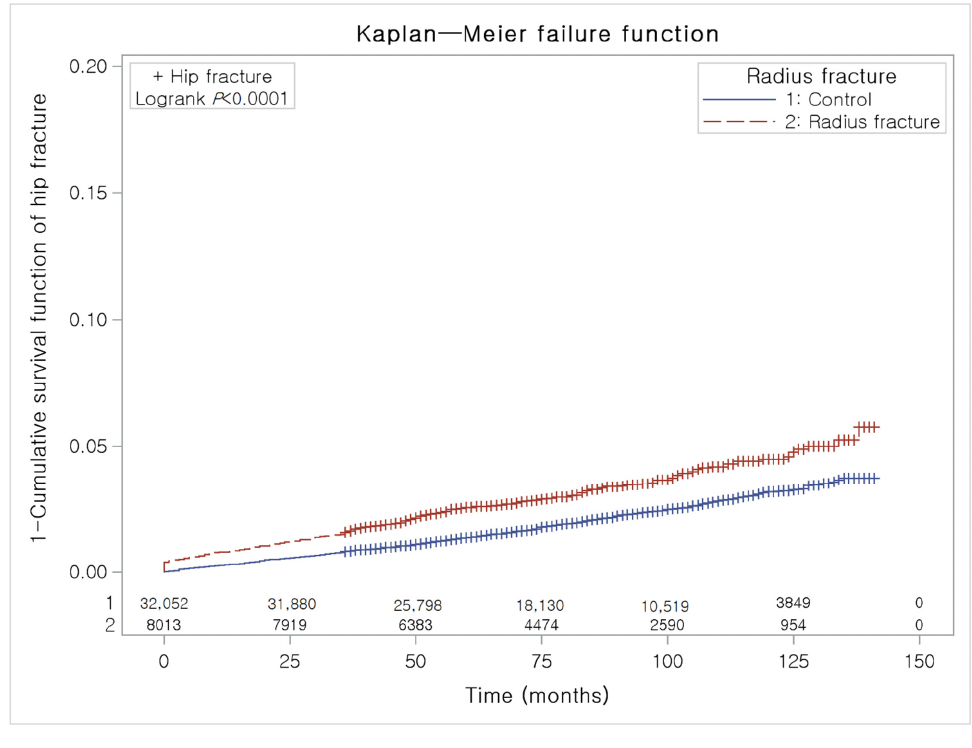
Figure 2. A Kaplan–Meier analysis of the incidences of hip fracture in the distal radius fracture group and the control group. During the follow-up period, the cumulative incidence of hip fracture in the distal radius fracture group was significantly higher than that in the control group.